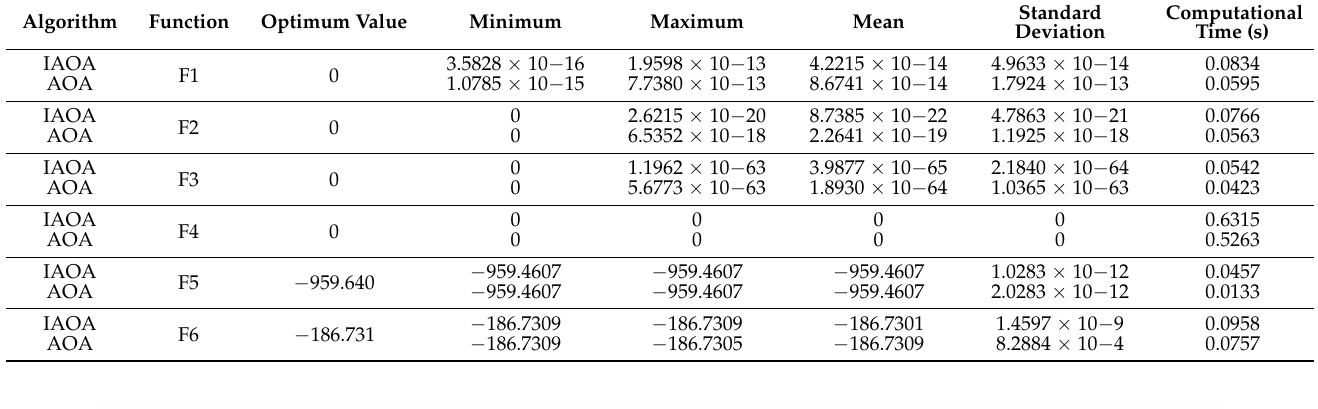
Table 2. Performance analysis for AOA and IAOA algorithms.